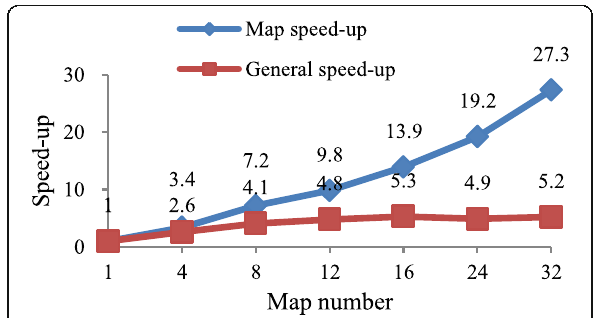
Fig. 6 The speed-up rate of 2 GB on different cores. The figure compares the Map speed-up and General speed-up of a 2-GB file under different cores in parallel environments